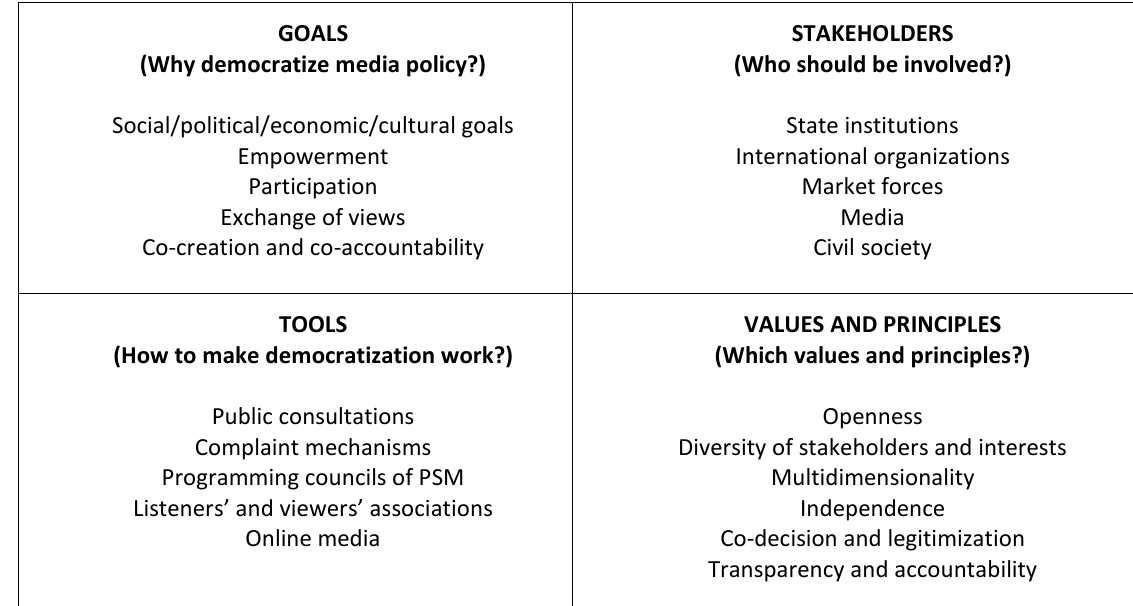
Figure 1. Selected dimensions of media policy democratization. Source: Based on Jaskiernia and Głowacki (2015, p. 12). Aslama (2010), Krichels (2014) and Leurdijk